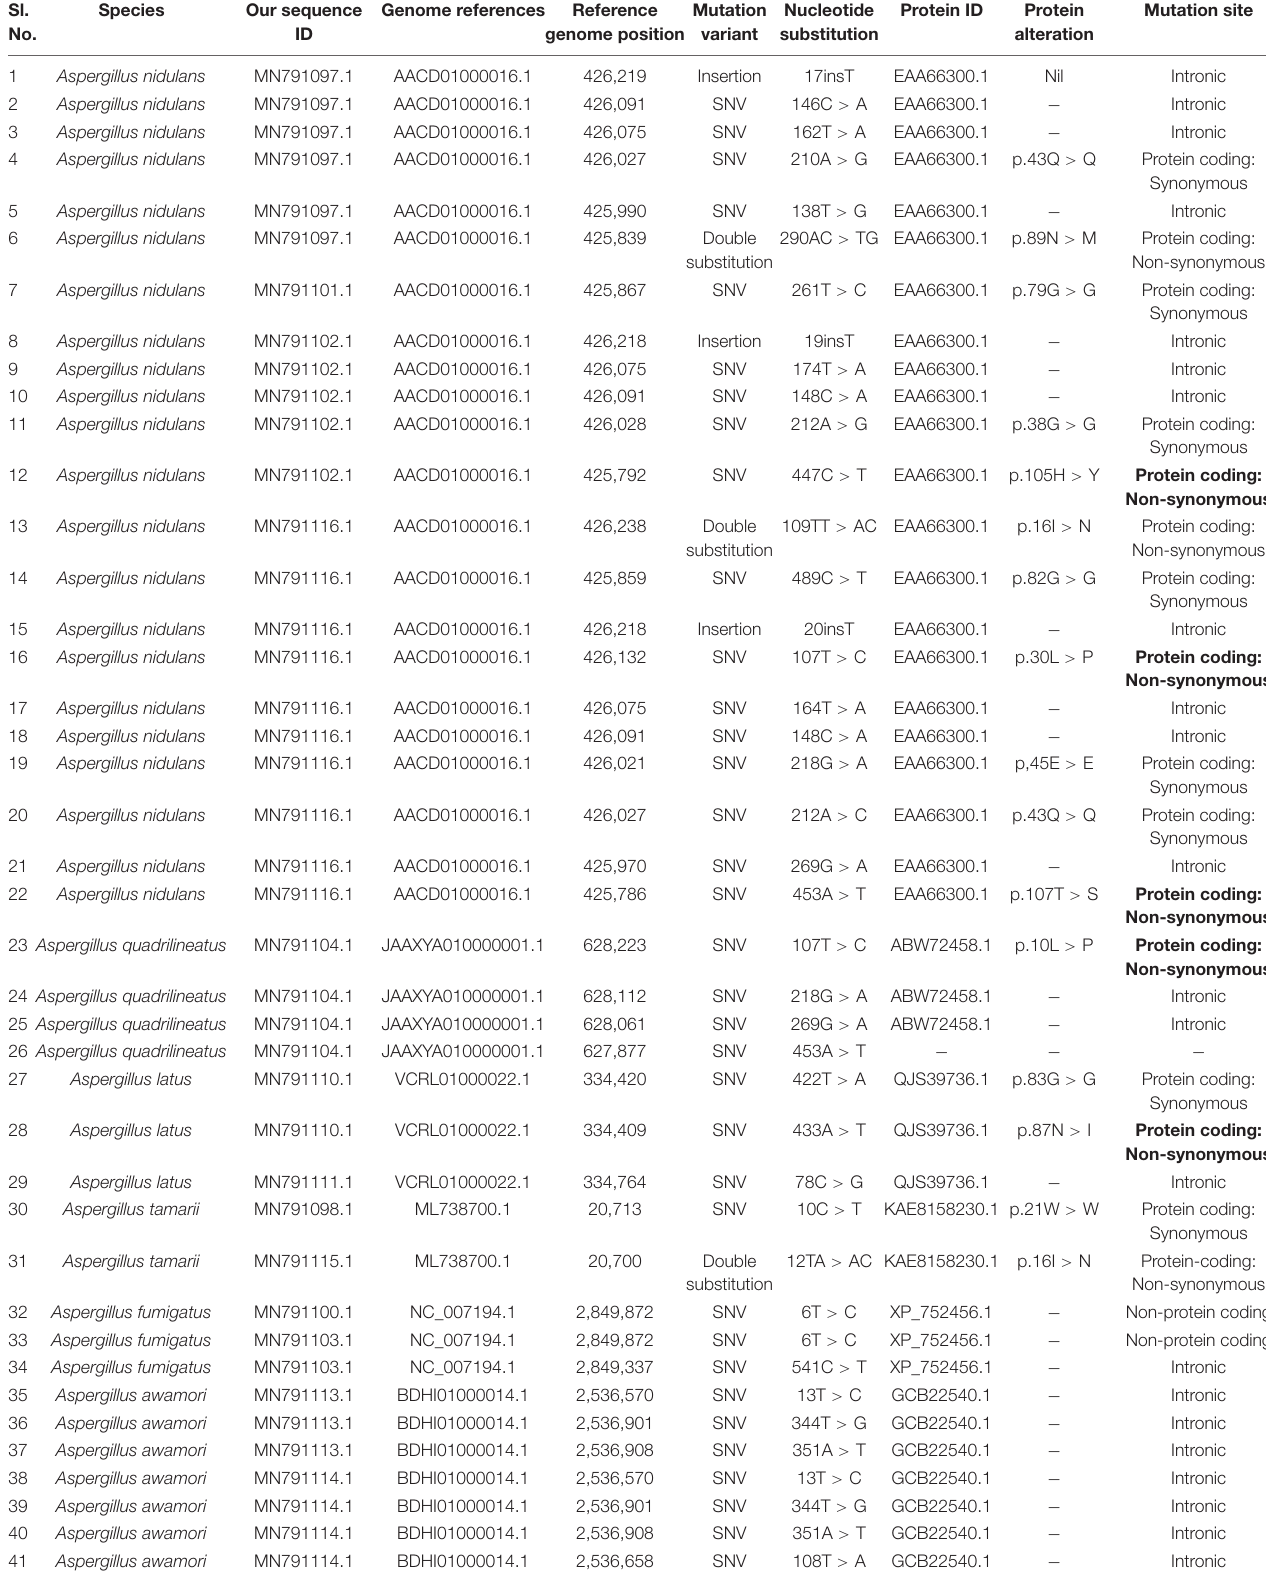
TABLE 2 | Sanger’s sequencing data to provide a list of protein-altering mutations. Sl.